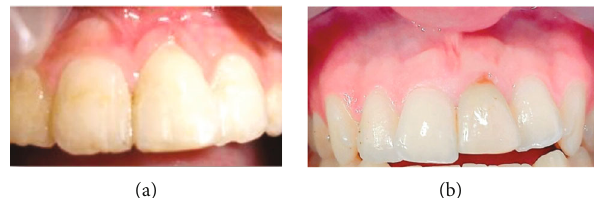
Figure 2: (a) The clinical view after the splint was removed and incisal adjustment was performed. (b) Clinical photograph at 10-year